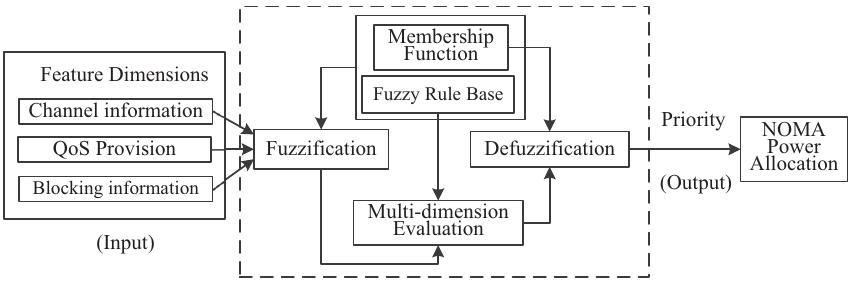
Figure 2. Fuzzy logic scheme. The labels NOMA and QoS are non-orthogonal multiple access and quality of service,